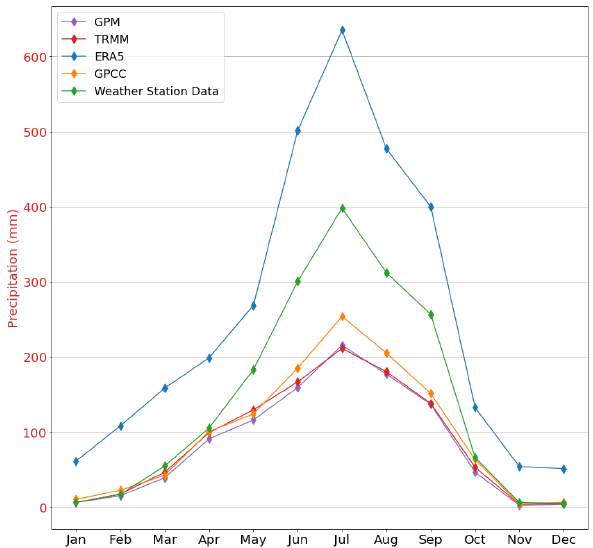
Figure 3. Annual precipitation for the region 89°–92° E, 27°–28° N, covering the locations of the weather stations in Bhutan, from ERA5, GPCC, TRMM, and GPM precipitation data sets and the weather station records. Values shown represent the average rainfall over the period 2012 to 2019